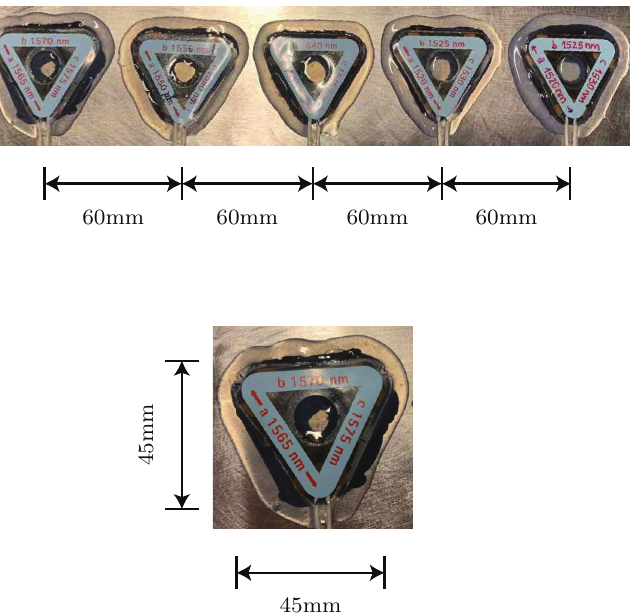
Figure 2. A strain gauge array formed of five fibre Bragg grating rosettes.